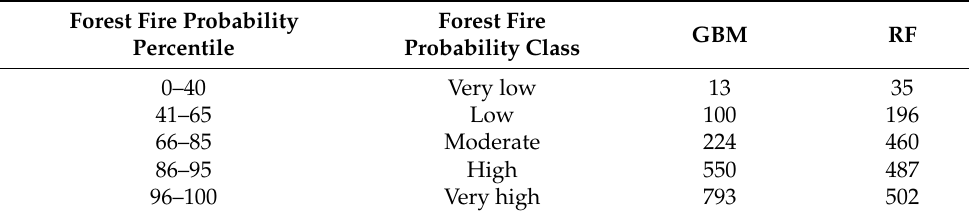
Table 2. Forest fire distribution across different probability classes based on GBM and RF models for the study area.